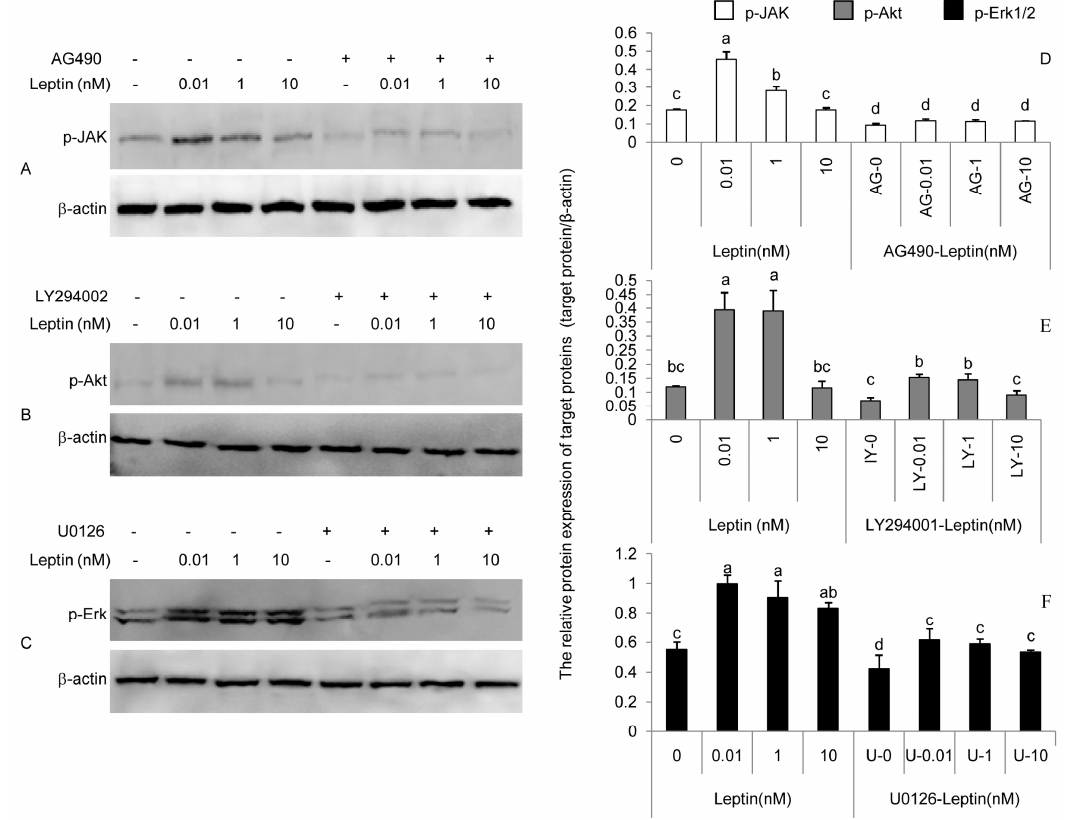
Figure 2. Effects of leptin and inhibitors on the protein expressions of p-JAK2, p-Akt, and p-Erk1/2 in primary porcine endometrium epithelial cells (PEECs) in response to leptin and inhibitors. A – C : Western blot analysis (WB) pictures of p-JAK2, p-Akt, and p-Erk1/2. D – F : Quantification of the WB